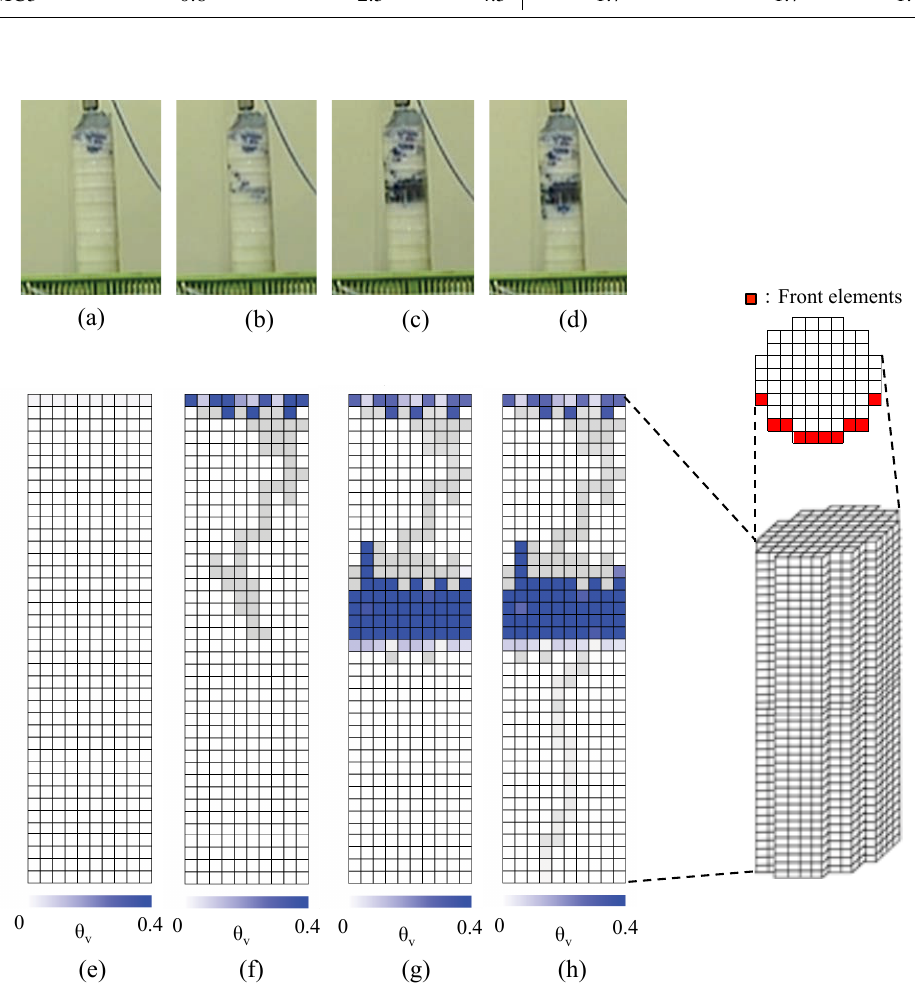
Figure 1. Development of the capillary barrier and preferential flow path for FC1 during experiments (a–d) and simulations (e–h) . A blue dye tracer was used in the experiment. In the simulation images, blue denotes the liquid water content at the front elements (see the right figure), while grey denotes that the front elements are dry, but some liquid water is present within the sample at that position. The grey scale represents the maximum liquid water content for each location. Captured times were at (a) 20s, (b) 35min, (c) 1h 25min, (d) 1h 29min, (e) 20s, (f) 17min, (g) 1h 19min, and (h) 1h